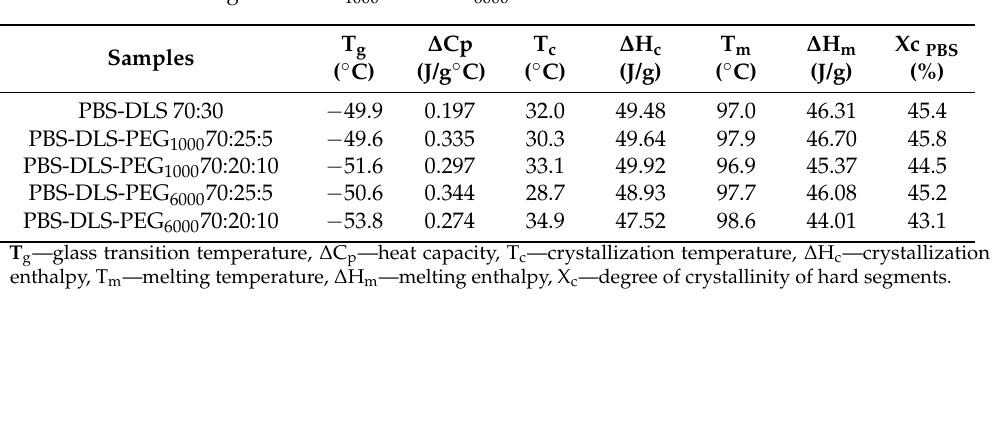
Table 5. Summary of DSC analysis of newly synthesized PBS-DLS-PEG copolymers with two different molecular weights of PEG 1000 and PEG 6000